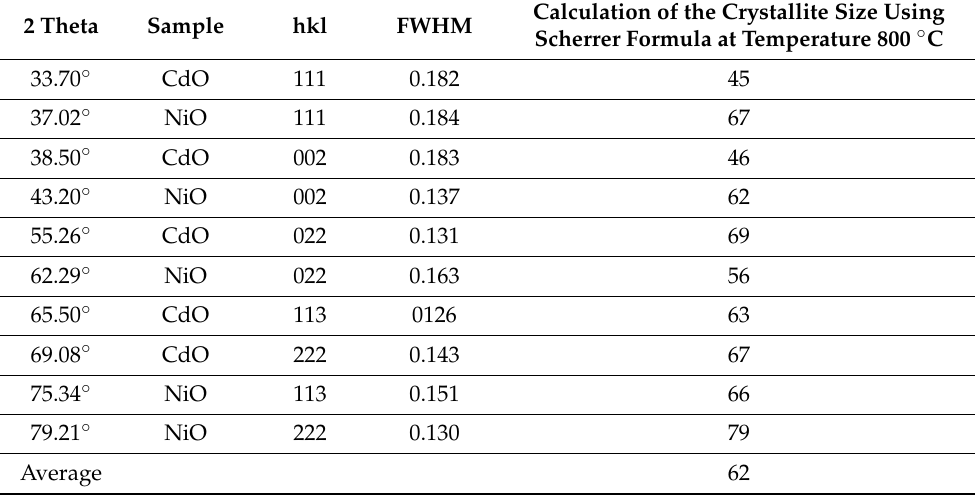
Table 1. XRD results of the prepared sample were calculated using diffraction peak by Scherrer formula at temperatures of 800 ◦